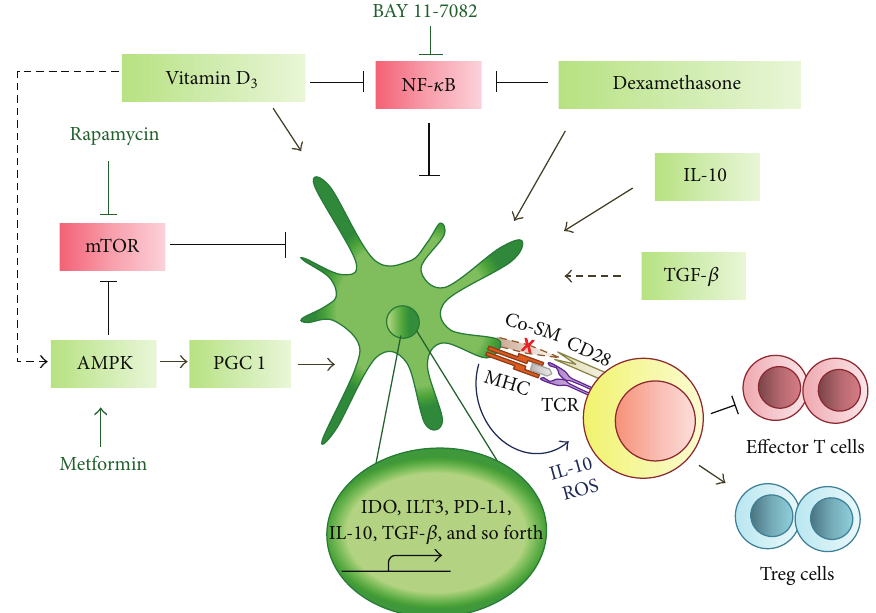
Figure 2: Induction of tolerogenic dendritic cells by cytokines and pharmacological agents. Tolerogenic dendritic cells can be induced by TGF- 𝛽 (transforming growth factor-beta), IL-10 (interleukin-10), and pharmacological agents dexamethasone, BAY 11-7082, vitamin D 3 , rapamycin, and metformin which regulates dendritic cell metabolism. The induction of tolerogenic dendritic cells leads to an increase in IDO (indoleamine 2,3-dioxygenase), ILT3 (Ig-like inhibitory receptor 3), PD-L1 (ligand of programmed death 1), IL-10, and TGF- 𝛽 transcription and expression. The downregulation of Co-SM (costimulatory molecules) on tolerogenic dendritic cells and the subsequent release of IL-10 and ROS (reactive oxygen species) result in the inhibition of T cells alloproliferation and the expansion of Treg (T regulatory cells), inducing